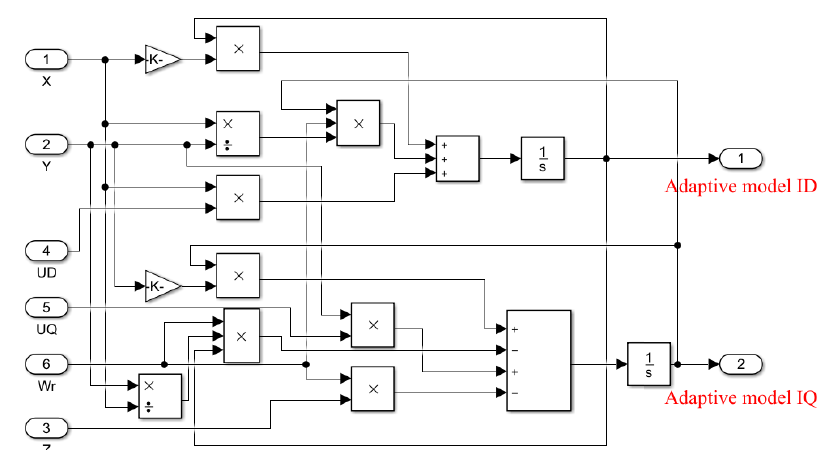
Figure 6. MRAA adjustable model.